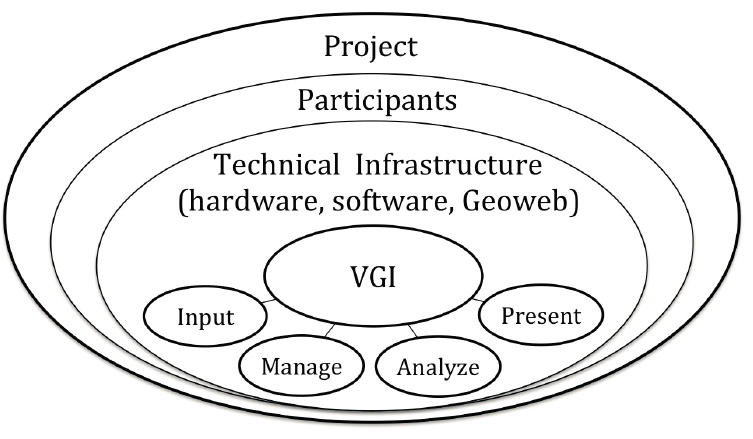
Figure 1. The components of volunteered geographic information (VGI)